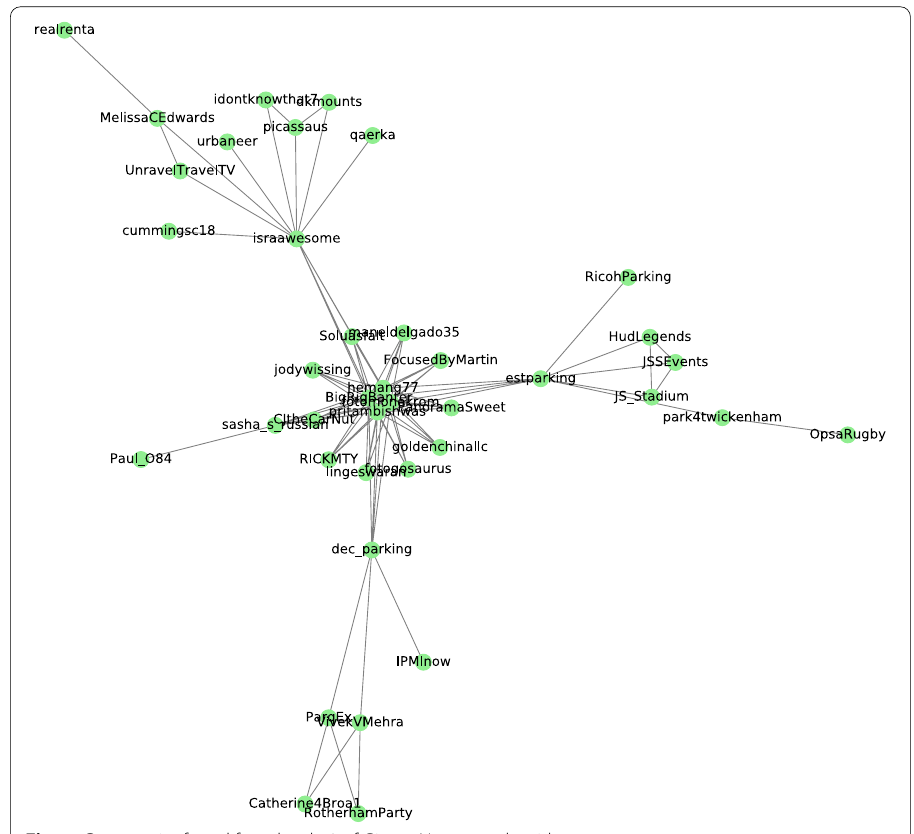
Fig. 7 Community found from level 10 of Girvan Newman algorithm